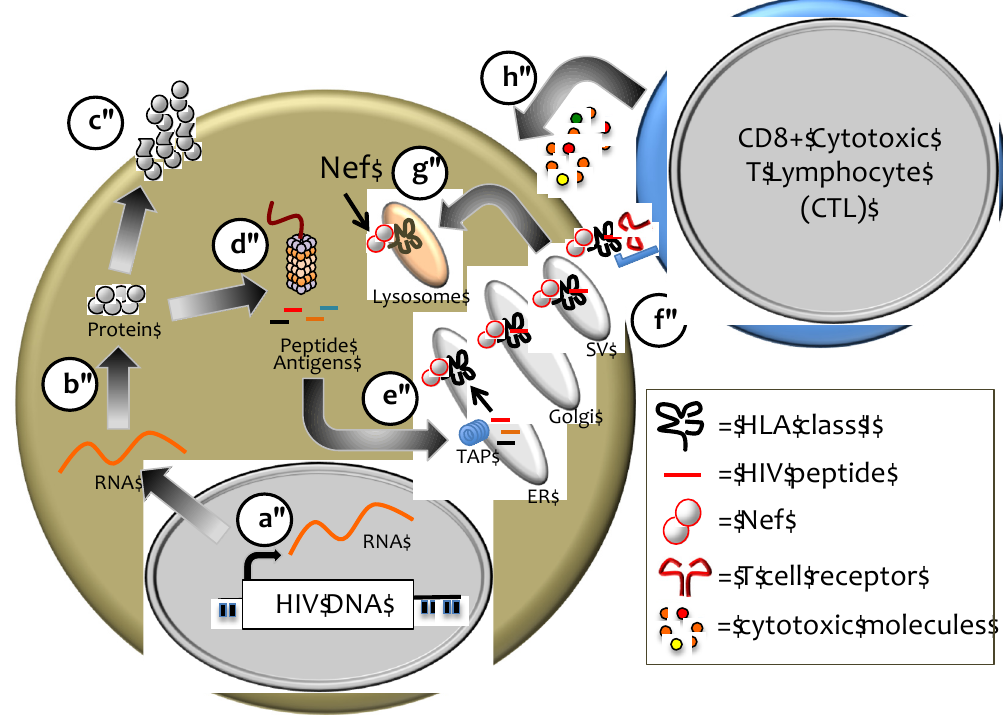
Figure 1. Presentation of viral peptide antigens by Human Leukocyte Antigen (HLA) class I. Human immunodeficiency virus type 1 (HIV-1) proviral gene expression, including RNA transcription ( a ) and protein translation ( b ); generates functional viral proteins ( c ) as well as truncated or mis-folded proteins that are degraded by the cellular proteasome complex to form short antigenic peptides ( d ); These peptides are transported from the cytoplasm into the endoplasmic reticulum (ER) ( e ) where they can be loaded onto HLA-I molecules. Peptide/HLA complexes traffic from the ER through the Golgi and secretory vesicle (SV) network to the plasma cell membrane, where the peptide antigens are presented to circulating cytotoxic T lymphocytes (CTL) ( f ); The viral Nef protein shuttles HLA molecules located at the cell surface or within the trans -Golgi network into lysosomal compartments ( g ); where they are degraded. In the absence of Nef-mediated HLA down-regulation, antigen-specific CTL respond to stimulation by releasing cytotoxic molecules, including perforin and granzymes, resulting in elimination of the virus-infected cell